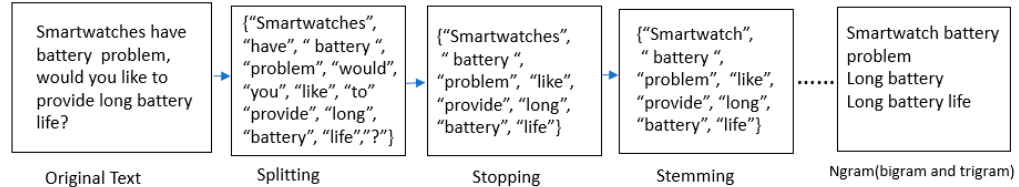
Figure 2. The demonstration of Natural Language Processing (NLP) steps to get candidate terms for requirements